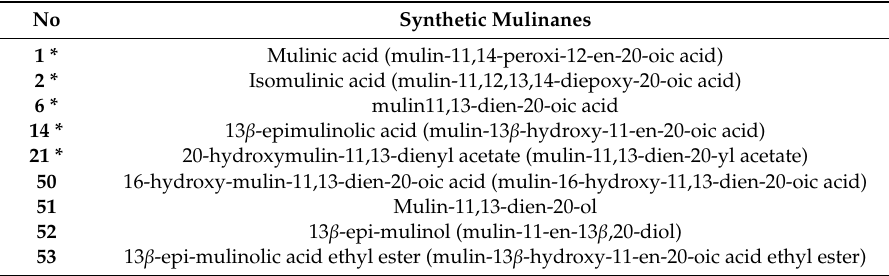
Table 2. Synthetic derivatives of mulinanes [53].